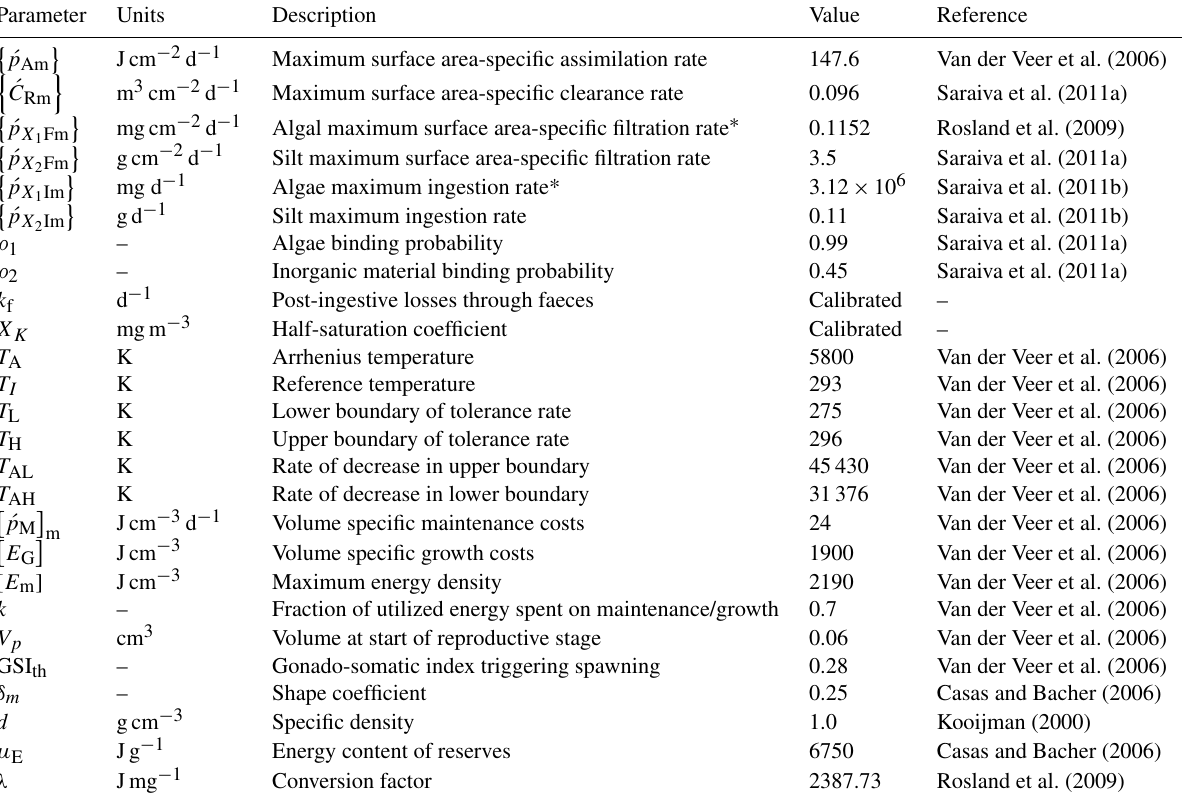
Table 3. Dynamic energy budget model: parameters.